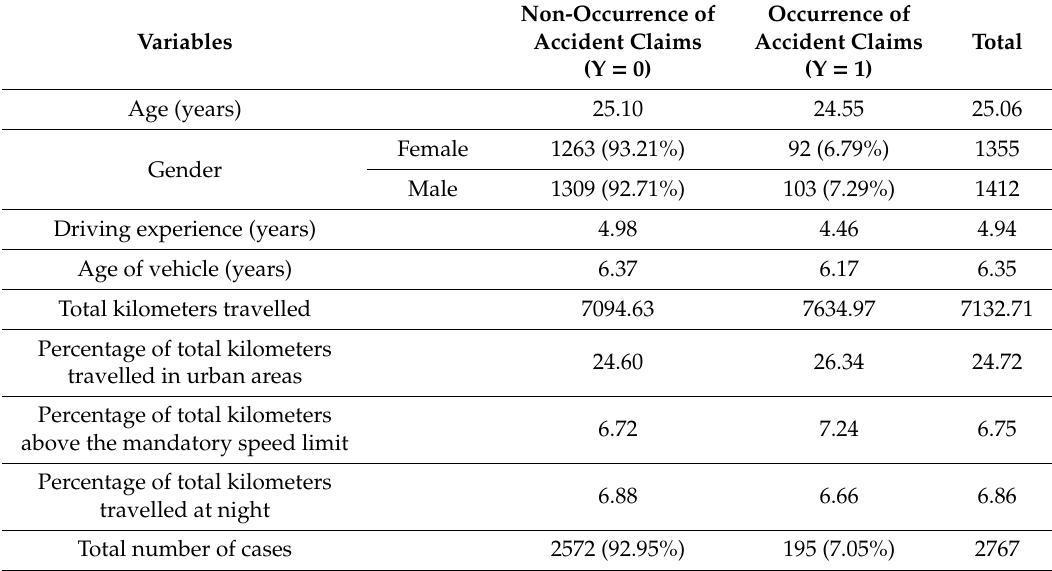
Table 1. The description of the variables in the accident claims data set 1